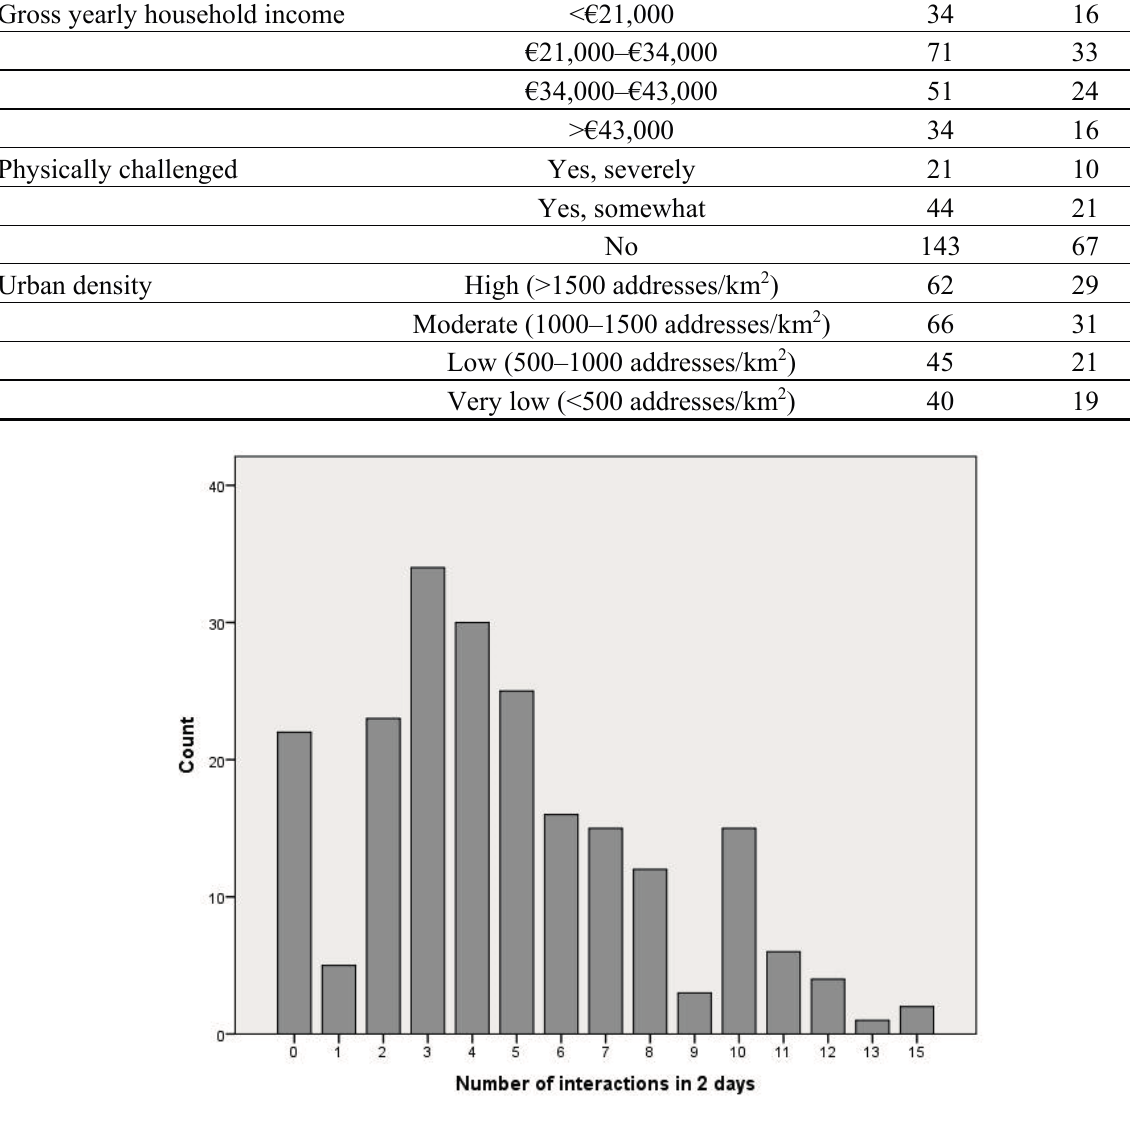
Figure 2. Number of recorded interactions in two days (N =